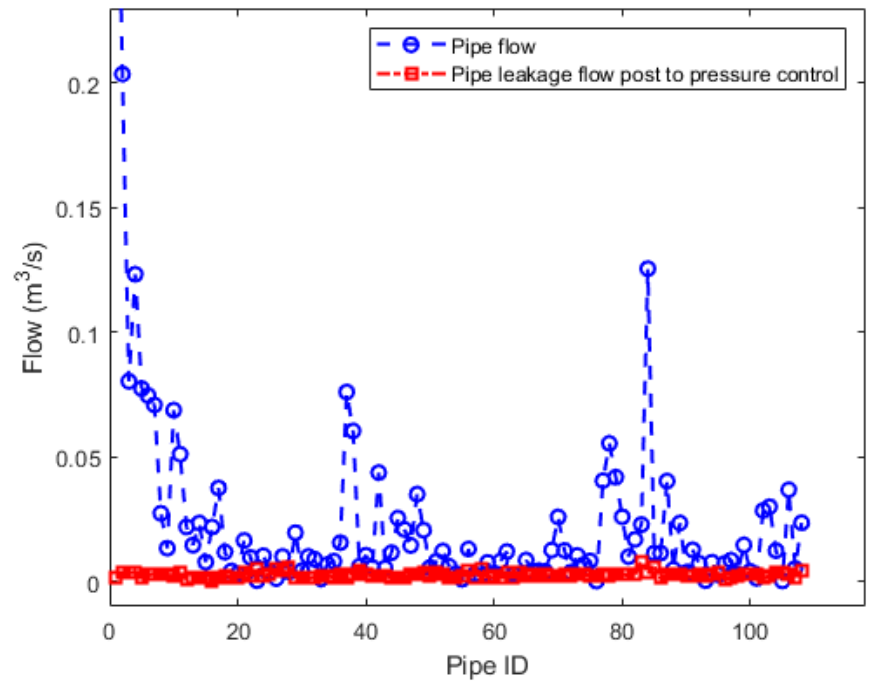
Figure 4. The actual flow and the leakage flow through the